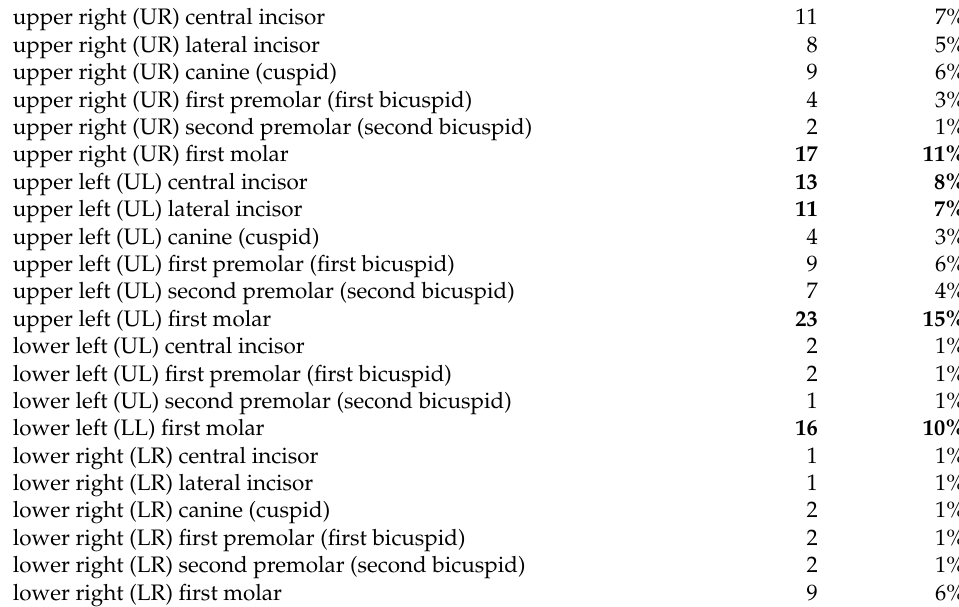
Table 4. The frequency of distribution of the affected teeth with WS lesion at